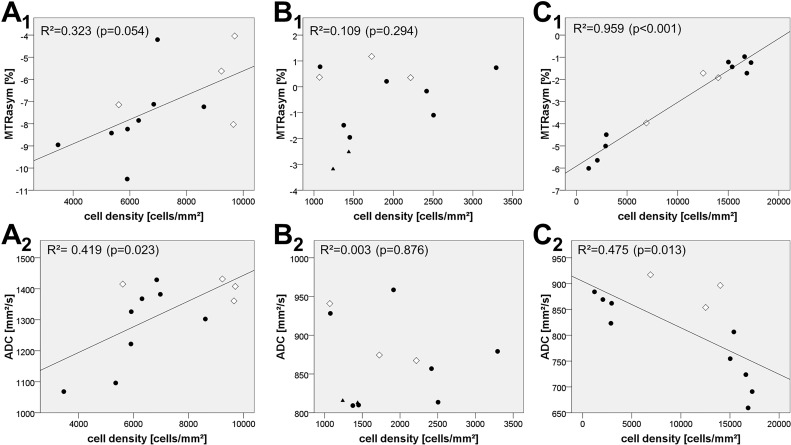
Tumor cell density and the corresponding MTRasym values/ADC values at the origin of the biopsy.• Biopsy from contrast-enhancing parts on CE-T1. ◊ Biopsy from necrotic areas as visible on CE-T1. ▲Biopsy from non-enhancing areas on CE-T1 (“edema”). A1/A2) 12 biopsies were obtained along a trajectory in a 67-year-old female with glioblastoma (patient 3). Linear regression of cell density and MTRasym values yielded R2 = 0.323 (p = 0.054). Linear regression of cell density and ADC values yielded R2 = 0.419 (p = 0.023). B1/B2) 12 biopsies were obtained along a trajectory in a 60-year-old female with glioblastoma (patient 4). Linear regression of cell density and MTRasym values yielded R2 = 0.109 (p = 0.294). Linear regression of cell density and ADC values yielded R2 = 0.003 (p = 0.876). C1/C2) 12 biopsies were obtained along a trajectory in a 45-year-old male with glioblastoma (patient 15). Linear regression of cell density and MTRasym values yielded R2 = 0.959 (p<0.001). Linear regression of cell density and ADC values yielded R2 = 0.475 (p = 0.013).